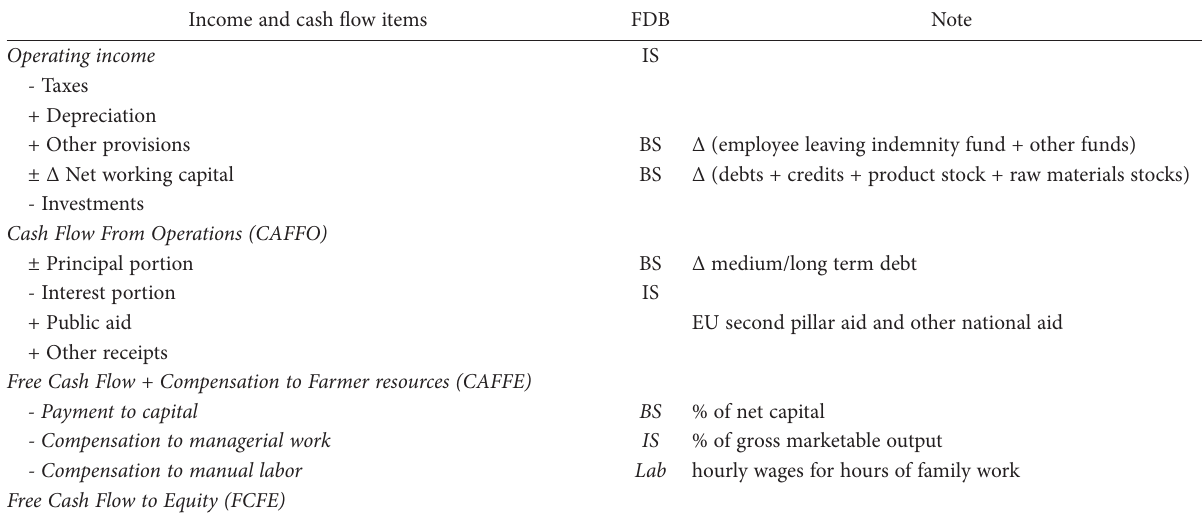
Table 1. FCFE Calculation: formulas and FADN Databases (FDB) used. Income and cash flow